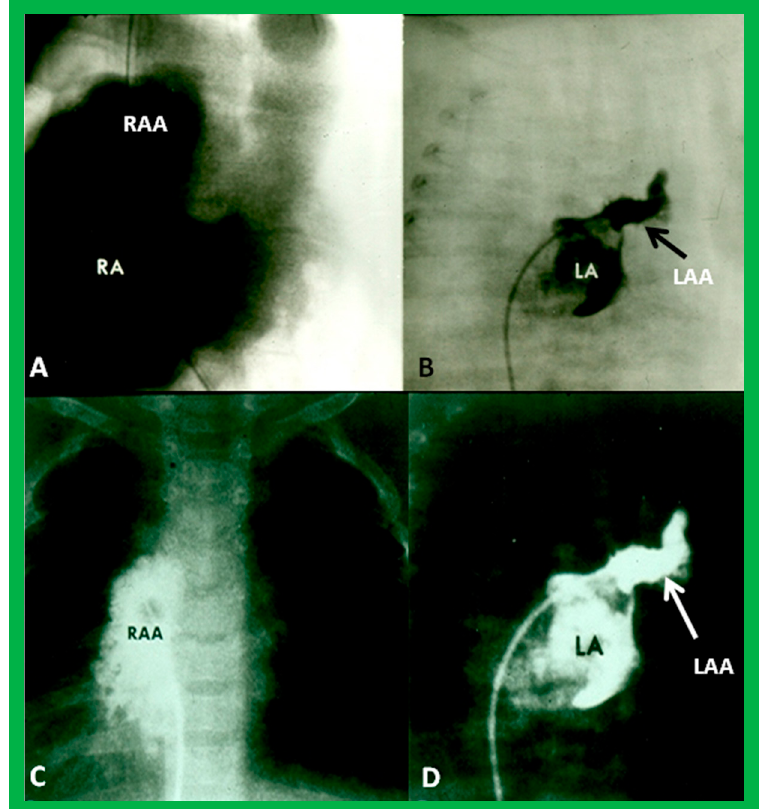
Figure 29. Angiographic images of right (RA) ( A , C ) and left (LA) ( B , D ) atria in a posteroanterior view illustrating the atrial appendage morphology. The RA appendage (RAA) has a broad, large, and pyramidal shape ( A , C ), whereas the LA appendage (LAA) has a narrow, small, and tubular shape ( B , D ). Reproduced from reference [4].